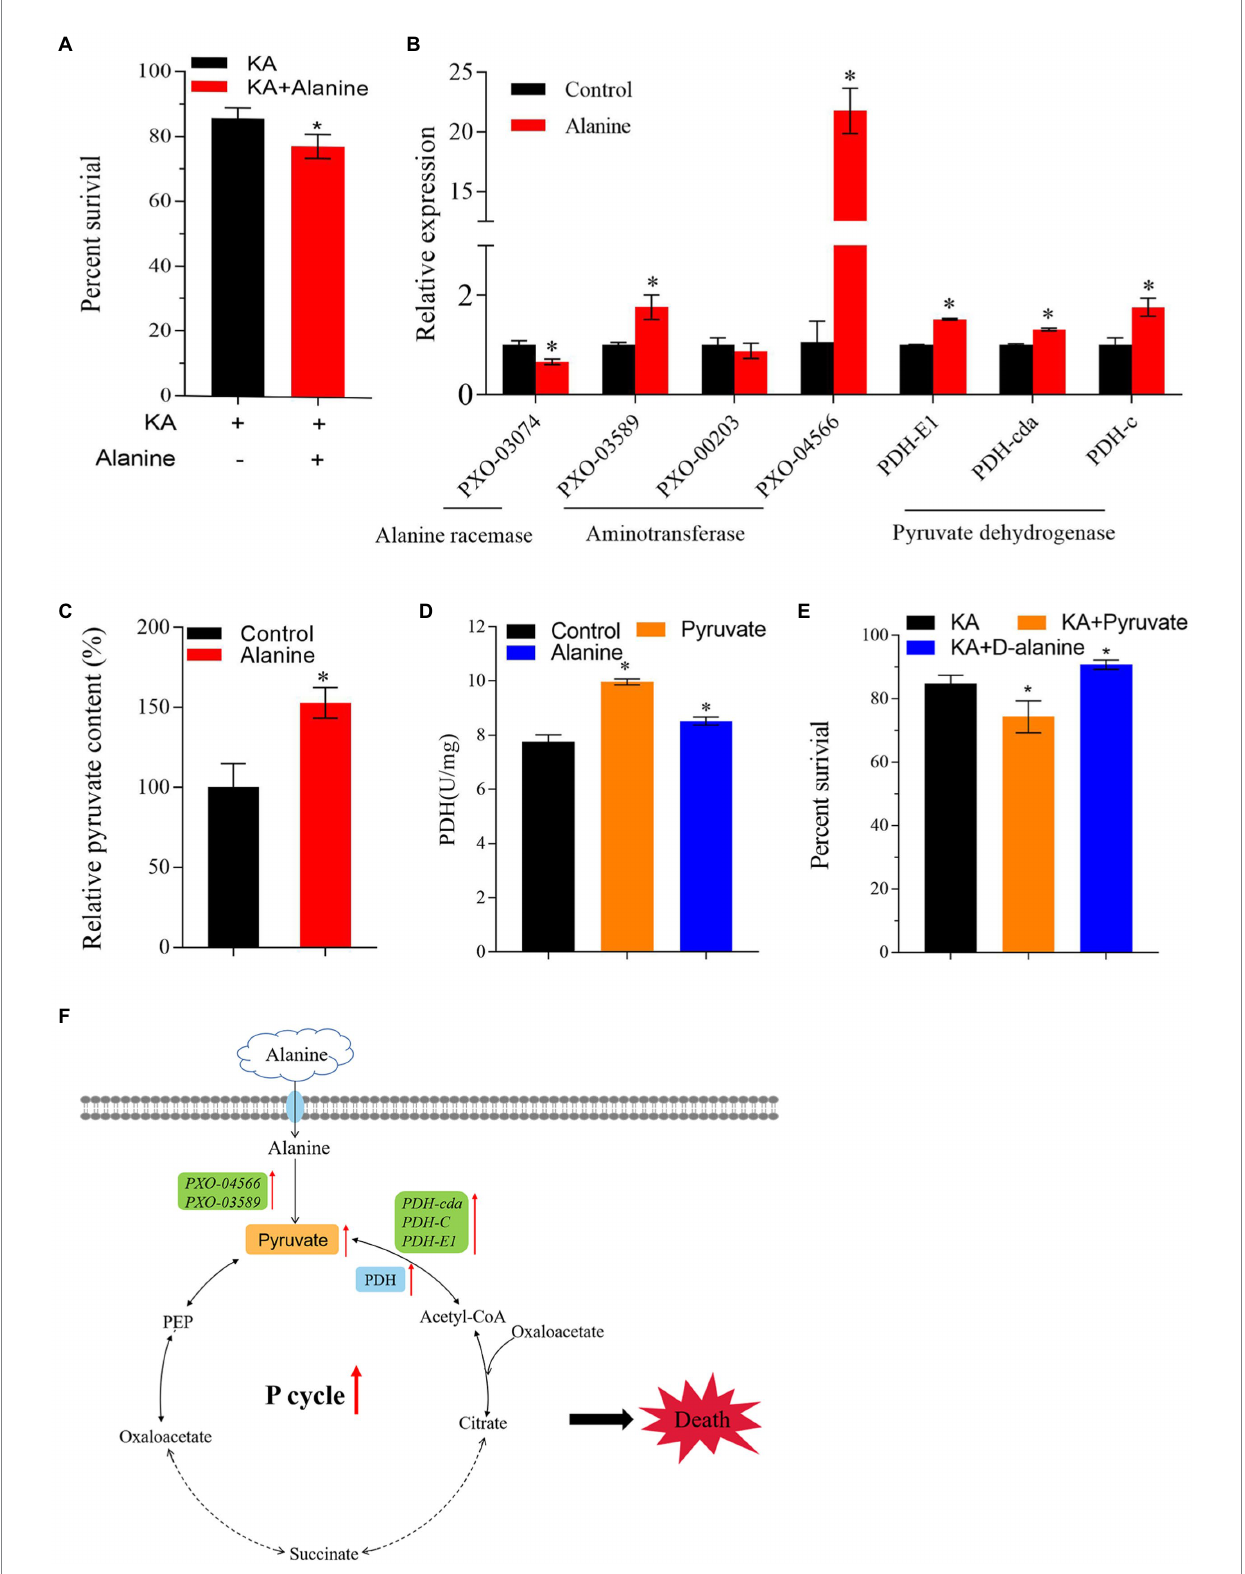
FIGURE 6 Exogenous Alanine reverses the KA resistance of Xoo-R KA. (A) Percentage of survival of Z173-R KA in the presence or absence of 40 mmol/L alanine plus 960 μ g/mL KA. (B) The transcriptional levels of alanine racemase, aminotransferase and PDH of Z173-R KA in the presence or absence of 40 mmol/L alanine. (C) The relative pyruvate content of Z173-R KA in the presence or absence of 40 mmol/L alanine. (D) Enzymatic activity of PDH of Z173-R KA in the presence or absence of 60 mmol/L pyruvate/40 mmol/L alanine. (E) Percentage of survival of Z173-R KA in the presence or absence of 60 mmol/L pyruvate/60 mmol/L/D-alanine plus 960 μ g/mL KA. (F) Metabolic pathway of alanine into the P cycle. Orange, blue and green shades represent content, enzyme activity and gene transcriptional levels, respectively. Results are reported as mean ± SD, and p values are identified (* p < 0.05) as determined by the two-tailed Student’s t -test. At least three biological repeats were carried